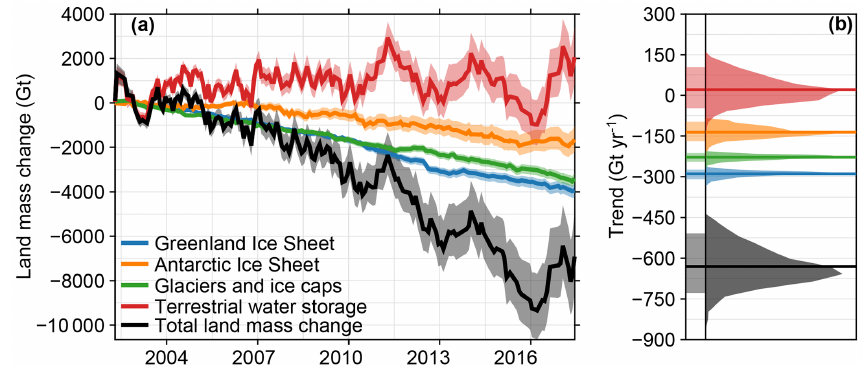
Figure 6. Total land mass changes as observed by GRACE, corrected for GIA. Panel (a) shows the expectation (thick line) and 90% confidence intervals (shade) of the mass change time series for each process and the total land mass change. Negative values denote land mass loss. Panel (b) shows the expected value (thick line), 90% confidence interval (left shade), and PDF (right shade) of the resulting linear trend. Table 1. Trends in land mass changes and corresponding barystatic sea-level changes. The numbers in brackets show the uncertainties expressed as the corresponding 5%–95% confidence intervals. A positive sign for the mass change correspond to an increase in the mass on land, and a positive sign of the barystatic trend denotes a global-mean sea-level rise. Mass change Barystatic sea-level (Gtyr − 1 ) change (mmyr − 1 ) Greenland Ice Sheet − 289 [ − 309 , − 273] 0 . 80 [0 . 75 , 0 . 85] Antarctic Ice Sheet − 135 [ − 168 , − 97] 0 . 37 [0 . 27 , 0 . 47] Glaciers − 228 [ − 245 , − 212] 0 . 63 [0 . 59 , 0 . 68] Terrestrial water storage 21 [ − 47 , 105] − 0 . 06 [ − 0 . 29 , 0 . 13] Total land mass change − 630 [ − 729 , − 508] 1 . 74 [1 . 40 , 2 .